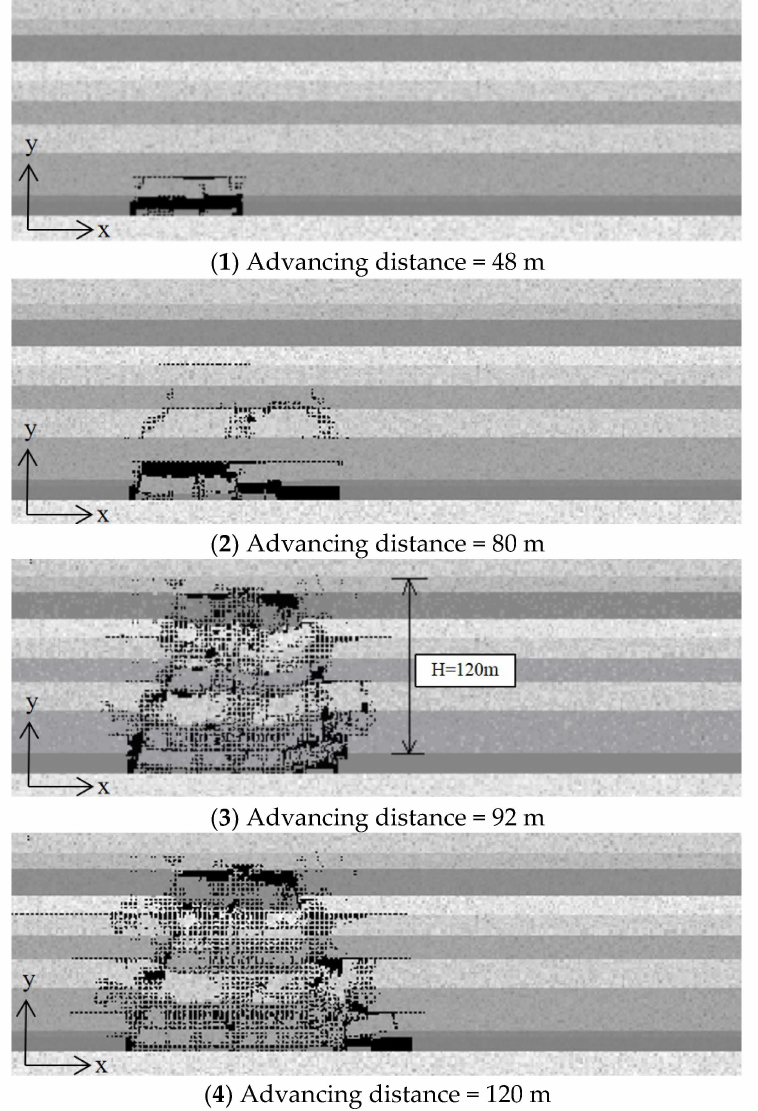
Figure 6. Dynamic simulation of overburden failure under fully mechanized mining